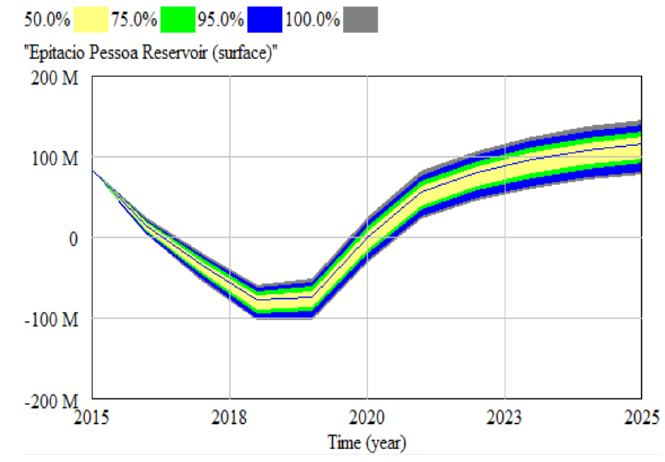
Figure 17. Monte Carlo simulation result for reuse wastewater.